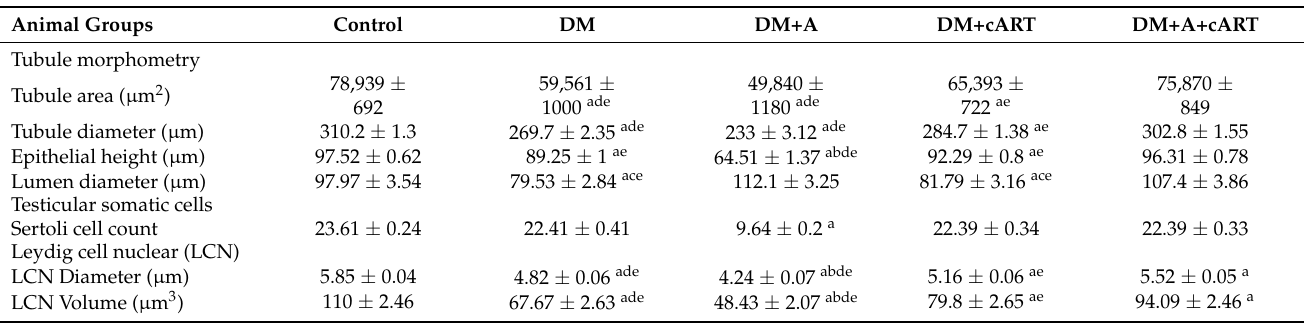
Table 2. Mean ± SEM tubule morphometry, Sertoli cell count, and Leydig cell morphometry of the animal